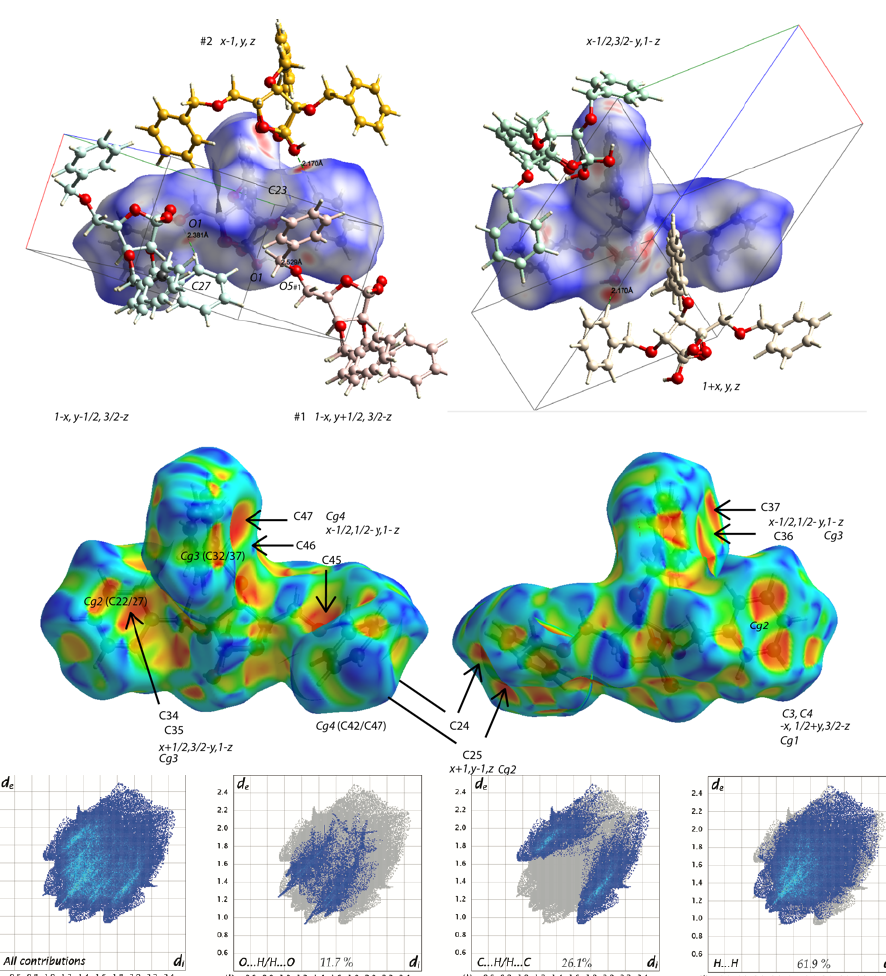
Figure 3. ( Top ) views of the 3-D Hirshfeld surface plotted over d norm in the range from − 0.3365 to 1.1653 a.u, ( Middle ) over the shape-index property highlighting C ‒ H… π interactions and ( Below ) the 2-D fingerprint plots of the mixture of D- showing close contacts of all contributions in the crystal and those delineated into the three main types of interactions. d i and d e denote the closest internal and external distances in Å from a point on the surface.